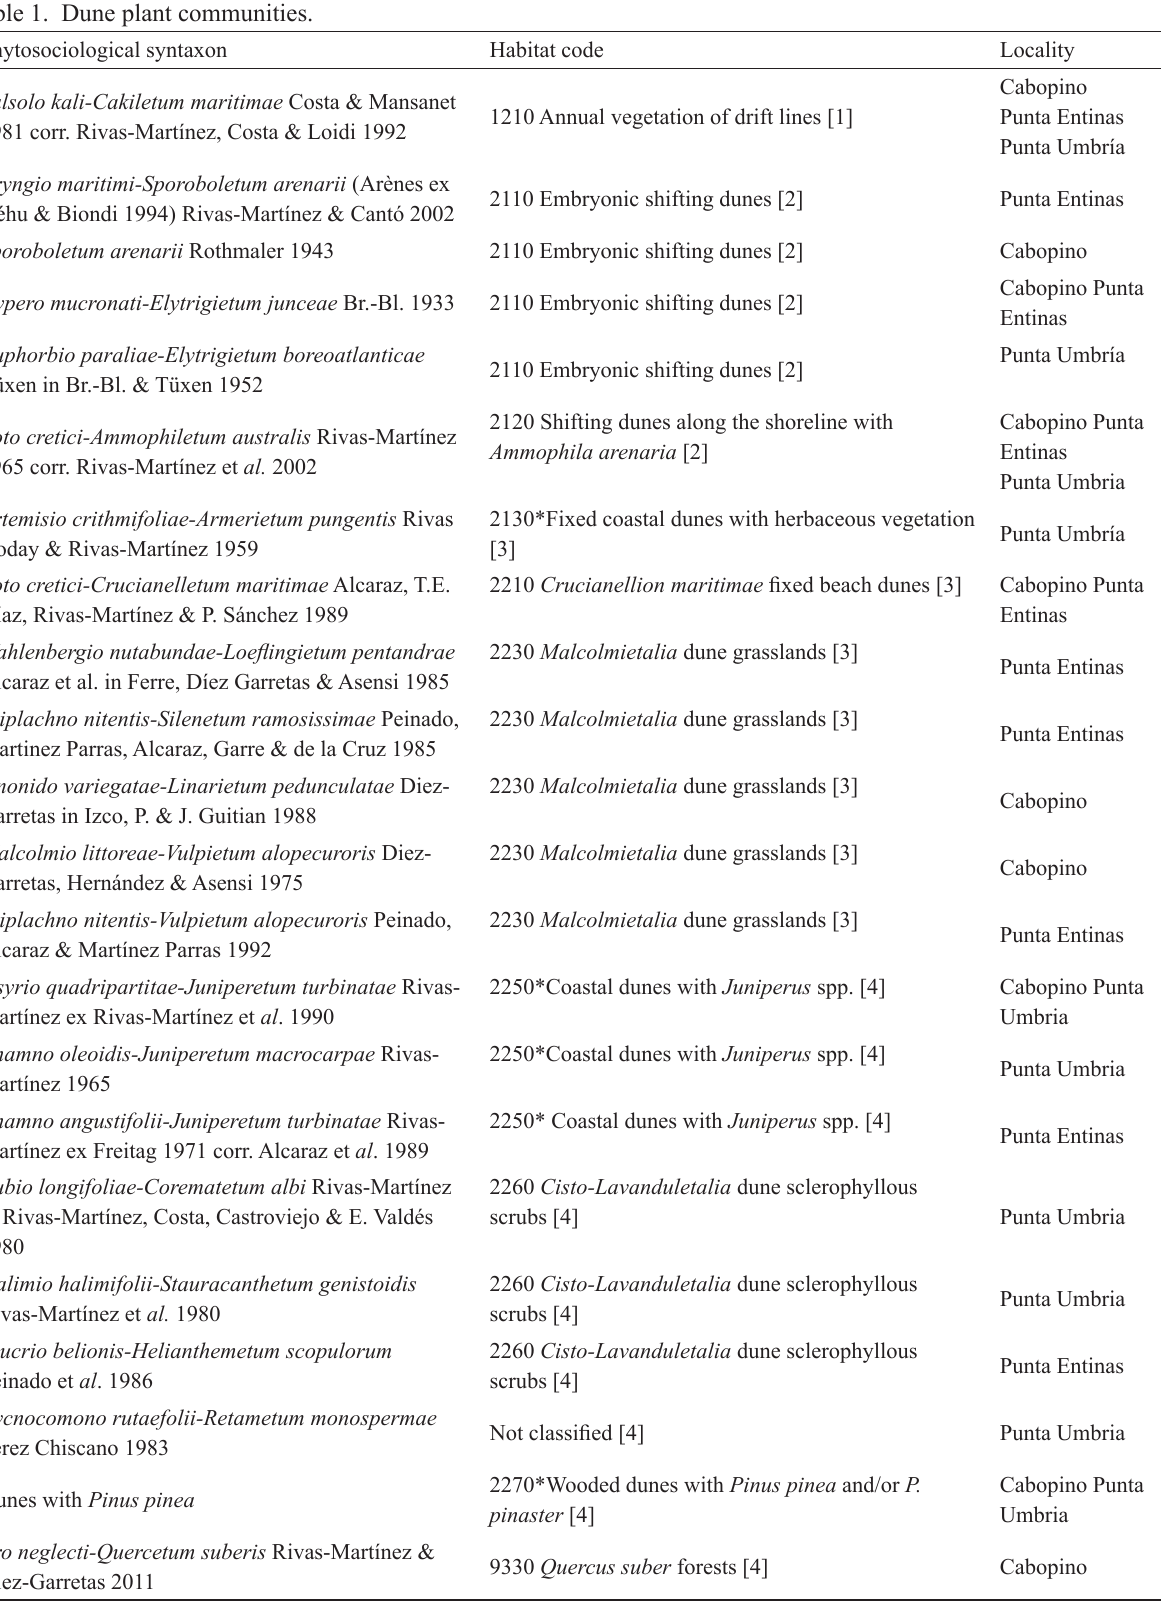
Table 1. Dune plant